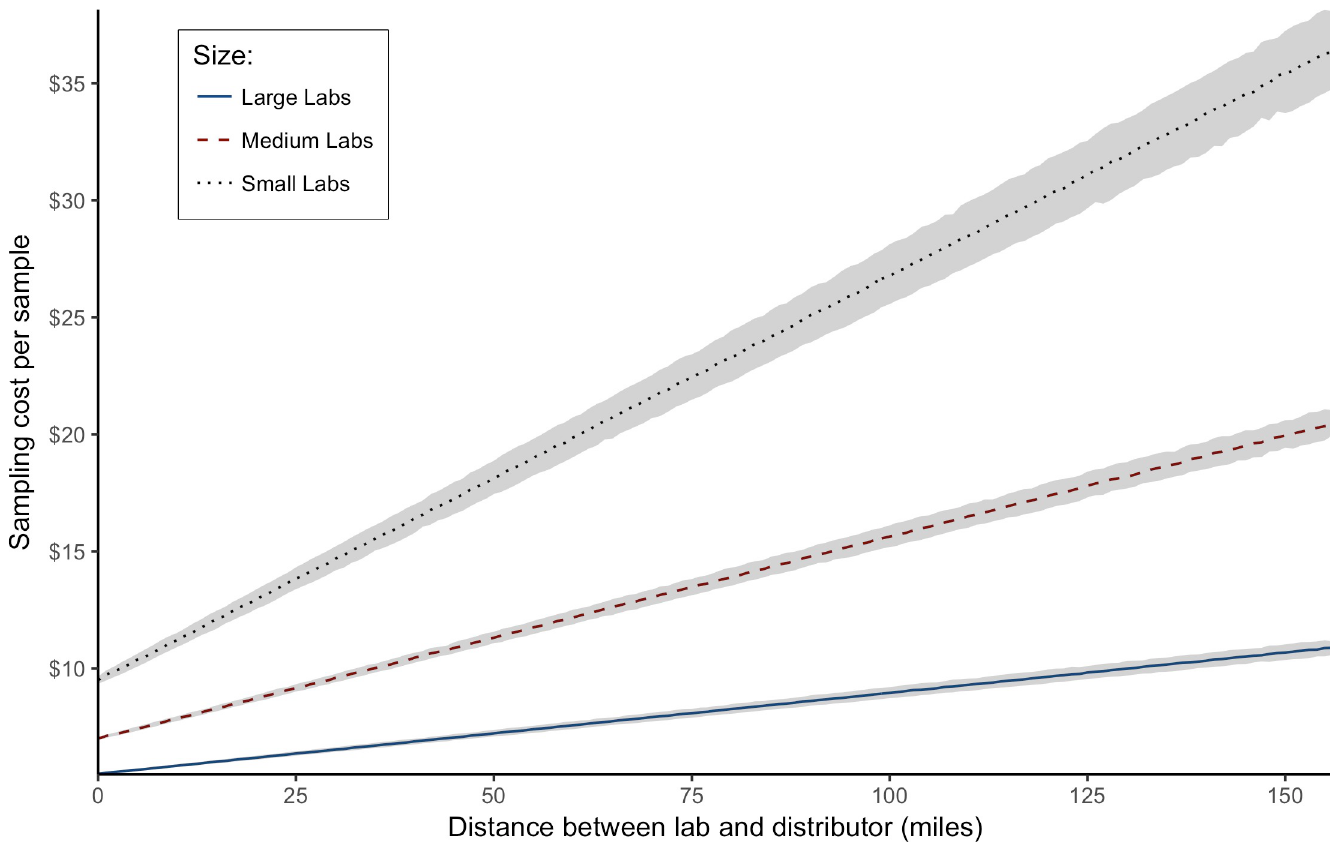
Fig 3. Sampling cost (collection, handling, and transportation) at different distances between a lab and a distributor.